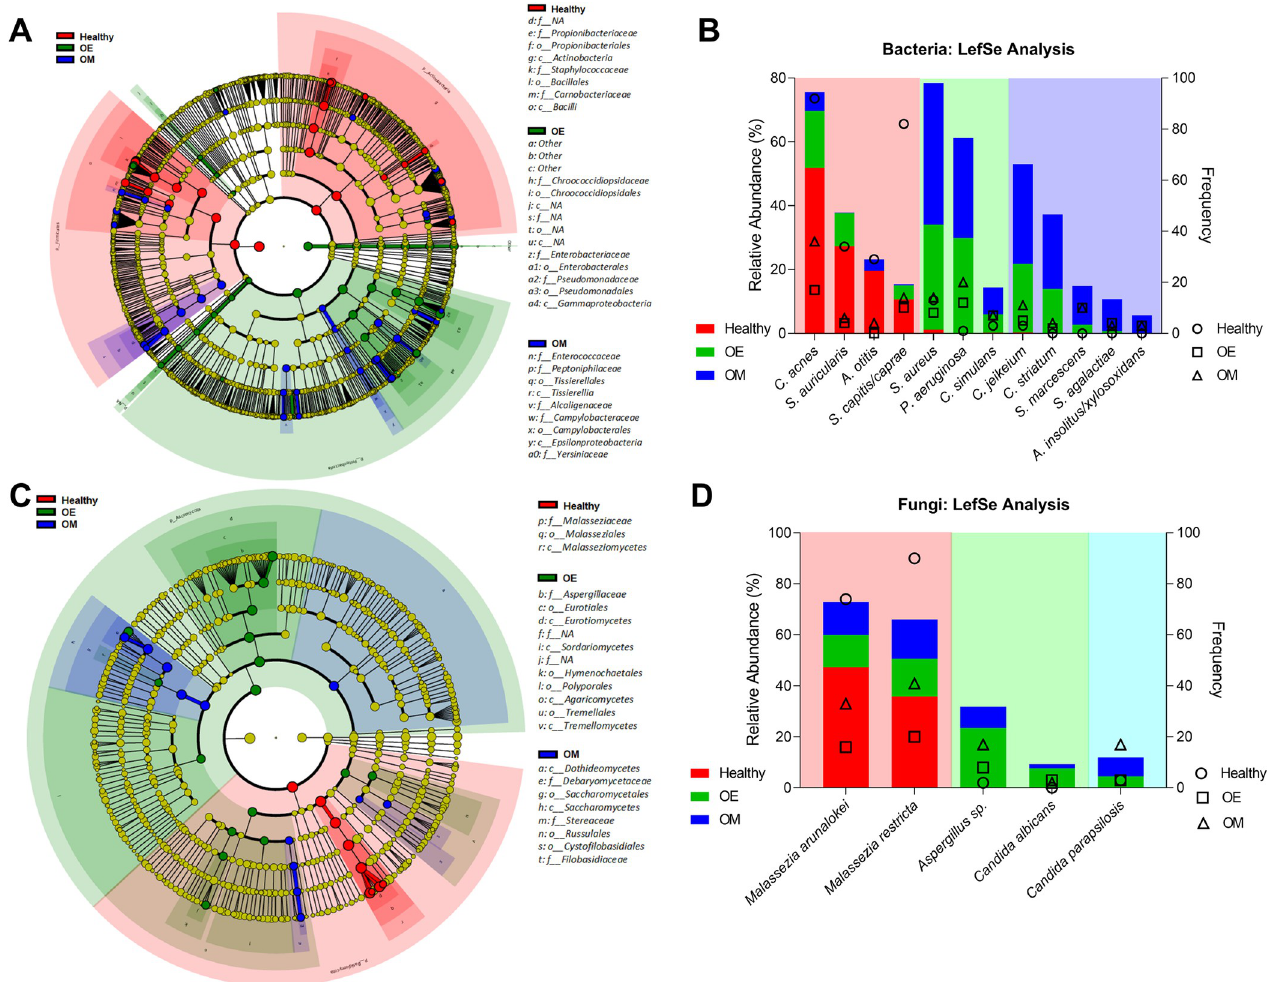
Fig 3. Linear discriminant analysis (LDA) effect size (LEfSe) analysis of otitis microbiota changes due to health context of the patient. Panels highlight taxa significantly different between groups at the phylum to genus level (A, C) and at the species level (B, D) for bacteria (A, B) and fungi (C, D), respectively. Cladograms: Regions in red indicate taxa that are significantly enriched in the healthy group, regions in green represent taxa enriched in the otitis externa group (OE), and regions in blue taxa that are significantly enriched in the otitis media (OM) group. Nods colored in yellow are not significantly different between groups. Each ring represents a taxonomic level, with the phylum level on the outside and the genus level in the innermost ring. Bar graphs: Shown are those species that were significantly different between groups with their relative abundances and frequencies for each group. To visualize the results, the average abundance of each significant species was used for the subset of the samples that had the species present. For readability of the figure, only the species that represented at least 5% of the bacterial or fungal microbiome, respectively are